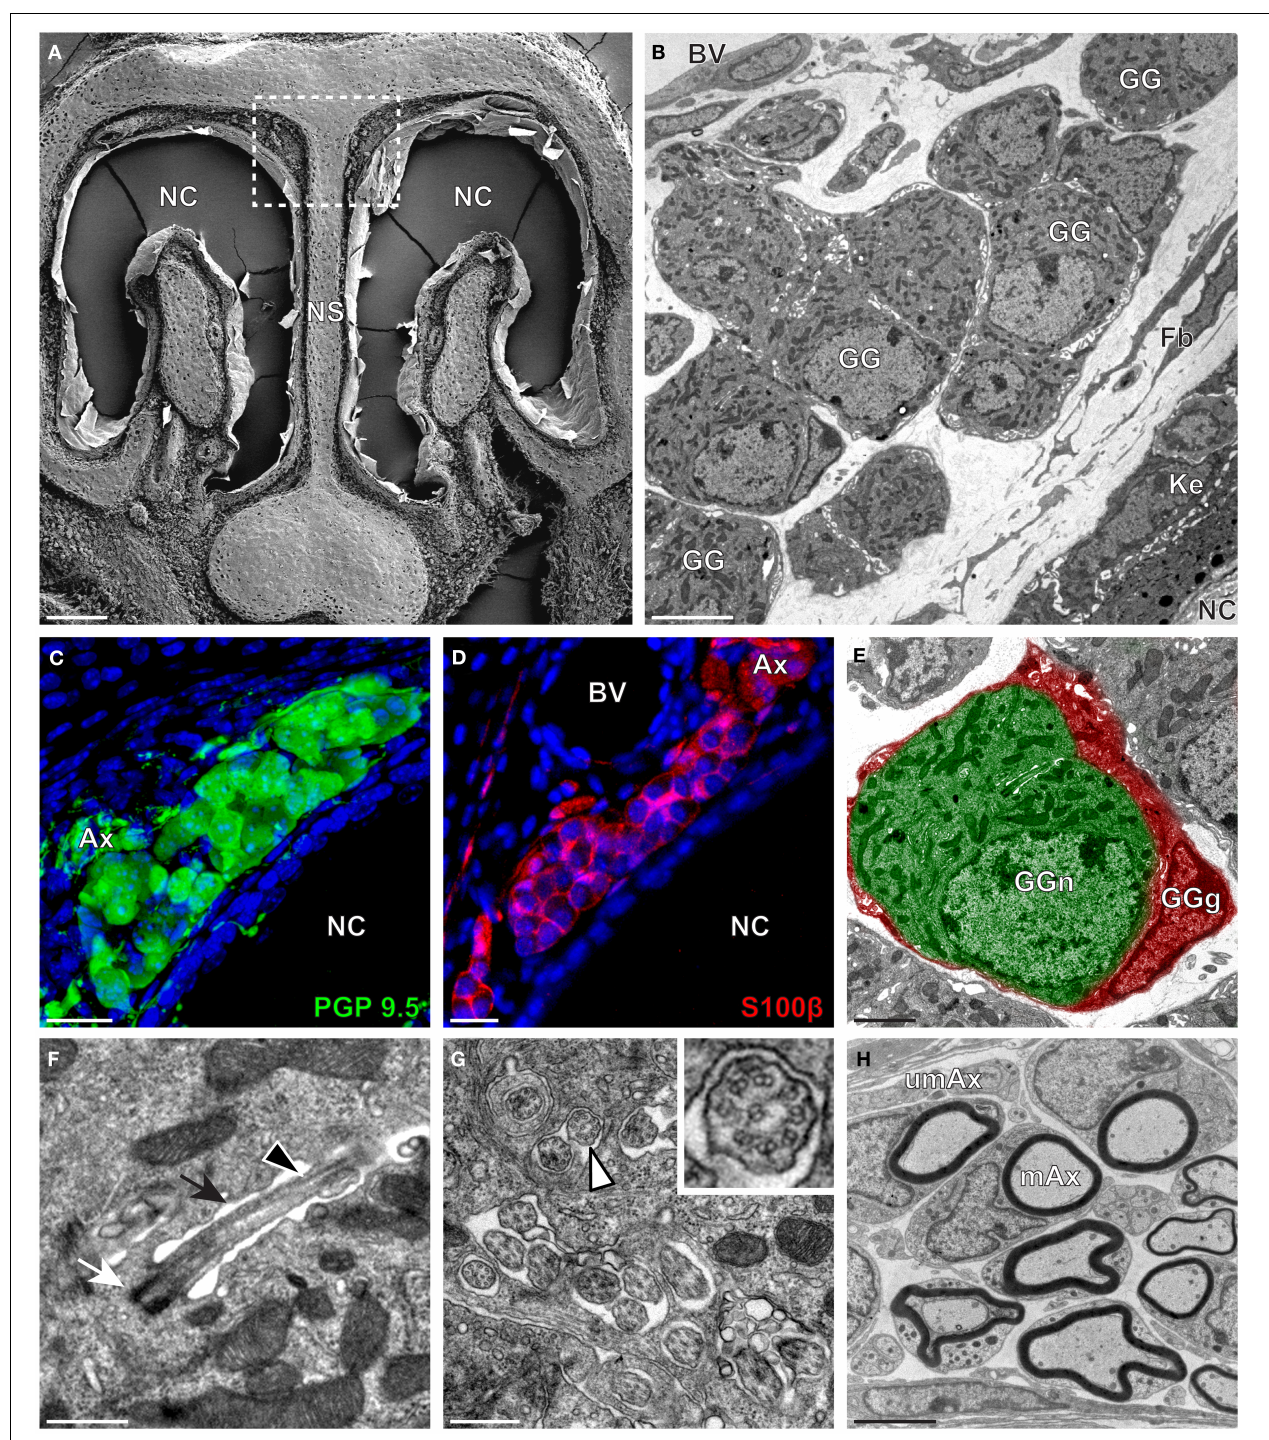
FIGURE 1 | Morphology and ultrastructural features of mouse GG. (A) General SEM view of a coronal slice performed in a mouse (P26) GG region. The nasal septum (NS) and the nasal cavities (NC) are shown. The white dashed rectangle highlights the GG region. (B) TEM observation of a group of mouse (P6) GG cells. The presence of a meshwork of fibroblasts (Fb) and a keratinized epithelium (Ke) separating the GG neurons from the